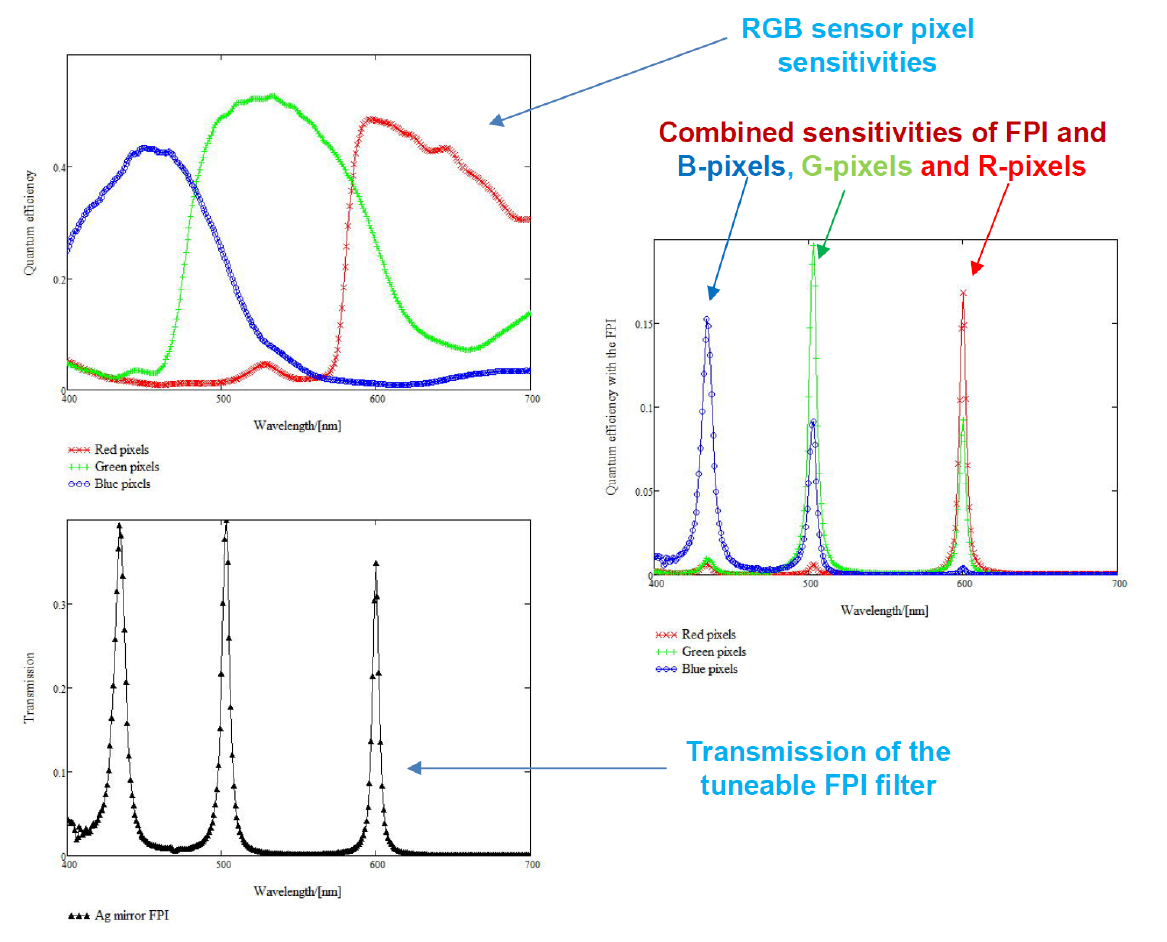
Figure 8. Quantum efficiencies of RGB CMOS image sensor (upper left) red, green and blue pixels, Transmission of metallic mirror FPI (lower left) and combined sensitivities of the FPI and red, green and blue pixels (upper right).